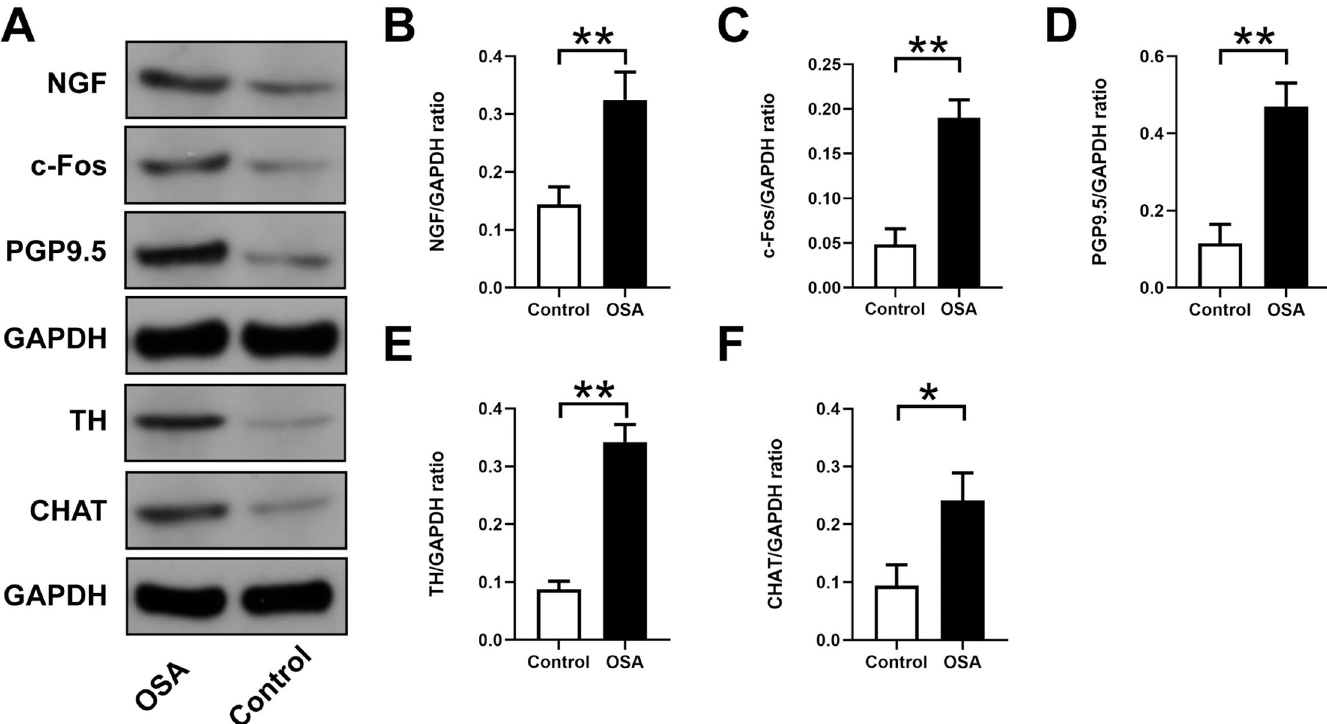
Fig 5. Expression levels of NGF, c-Fos, PGP9.5, TH, and CHAT in atrial tissues. (A) Western blotting results for NGF, c-Fos, PGP9.5, TH, and CHAT in the two groups. Relative protein expression of NGF (B), c-Fos (C), PGP9.5 (D), TH (E), CHAT (F) are shown and normalized to GAPDH. Abbreviations: NGF: nerve growth factor; TH: tyrosine hydroxylase; CHAT: choline acetyltransferase. � P < 0.05, �� P < 0.01 compared to control group.